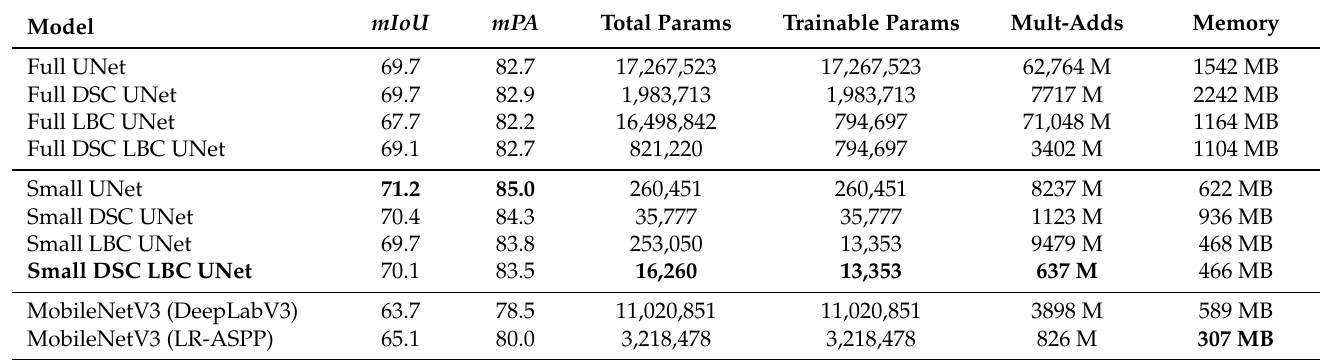
Table 1. Metrics, number of parameters, number of multiply–add operations and memory usage in the tested networks. Metrics were calculated by training three instances of each model, evaluating them on an external test set using weights saved at the stopping criterion, and averaging the three results. Memory and Mult-Adds were calculated using an input size of 320 × 320 × 3. Numbers in bold represent the highest metric or lowest number of parameters/operations/memory of the models tested. Small DSC LBC UNet is in bold as it shows a healthy trade-off between high performance metrics and low